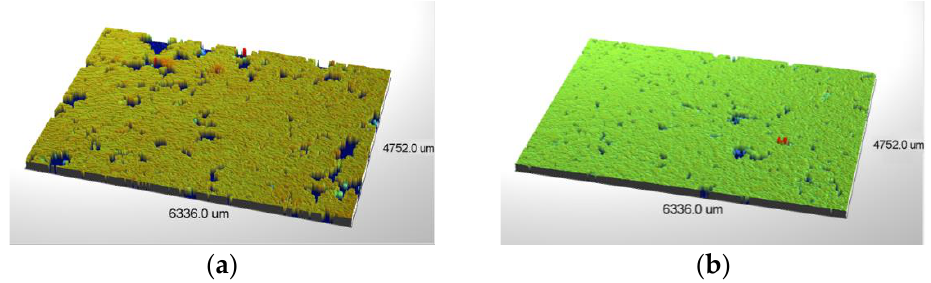
Figure 3. Surface micromorphologies of ordinary and ultrasonic vibration-assisted grinding. ( a ) Ordinary grinding and ( b ) ultrasonic vibration-assisted grinding.